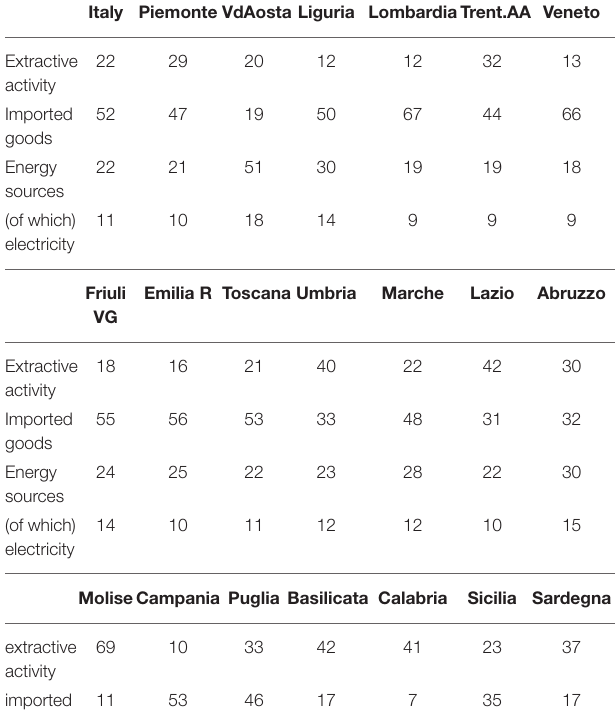
TABLE 2 | Percentage importance of the main resource aggregates of Italy and the 20 regions. Italy Piemonte VdAosta Liguria LombardiaTrent.AA